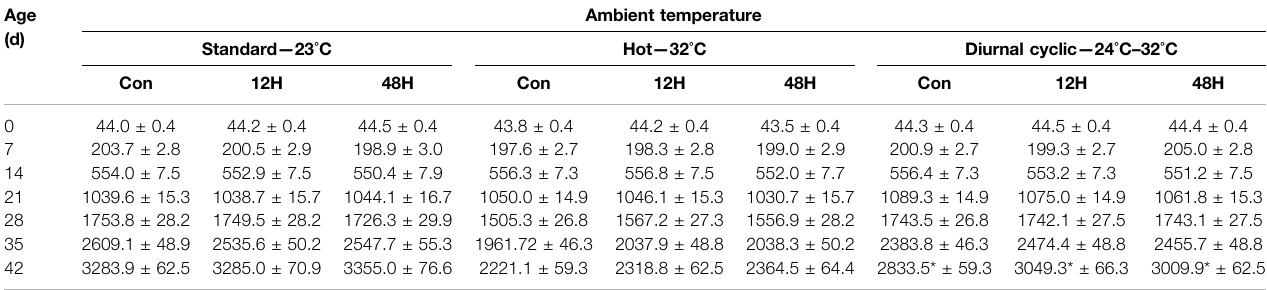
Means ± SE are presented. n = 20 for each incubation treatment group under each environmental condition. *On each day, Different letters indicate signi fi cant differences ( p ≤ 0.05) across incubation treatments within each ambient temperature.